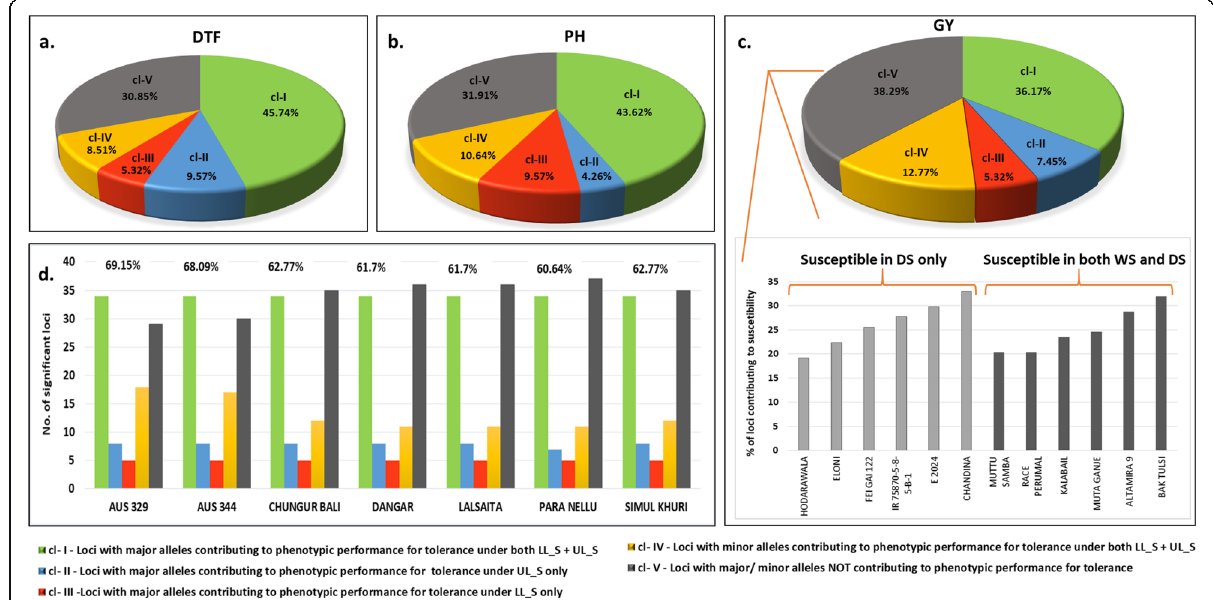
Fig. 9 Allelic variation at the significant GWAS-identified loci analysed to detect percentage composition of allelic profile in the selected 7 promising accessions based on presence of major or minor allele contibuting the phenotypic performance for tolerance under reproductive stage drought in lowland- LL_S and upland- UL_S in the two seasons for a . DTF; b . PH; c . GY. The five classes identified include three with loci where major allele present in all selected accessions contributed to trait mean under – LL_S + UL_S(cl-l); only UL_S (cl-ll) and only LL_S (cl-lll) while the fourth class comprises loci with minor allele present in selected accessions contributing to trait mean under both LL_S + UL_S(cl-IV). Class V (cl-V) comprises all the remaining loci out of the analysed 94, with neither major nor minor allele contributing to phenotypic performance for tolerance under drought in the selected accessions. The ClassV loci were analysed for contribution to low yield in 12 susceptible lines across LL_S and UL_S in either or both WS and DS. The variability in allelic variation for GY in the 12 susceptible accessions is depicted in the bar graph, divided in two categories-susceptible in both stress environments in DS only and in both seasons-WS and DS. d . Validation of selected accessions based on percentage of allelic variation contributing to grain yield under LL_S and UL_S- loci with favorable allele in each the selected accessions is divided along the first four classes and loci with unfavourable allele in each acession is represented by class V. The cumulative favourable allelic percentage of each accession associated with higher yield under drought is depicted by the percentage value mentioned on top of the bar columns. Details for loci associated with GY are mentioned in Table